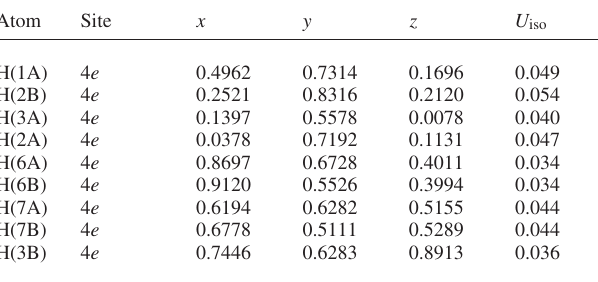
Table 2. Atomic coordinates and displacement parameters (in Å 2 )